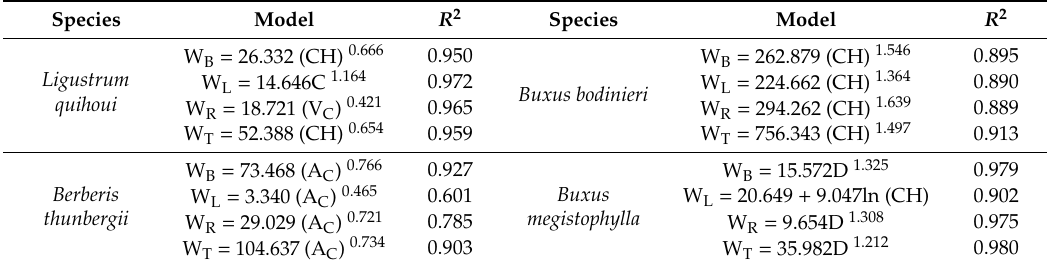
Table A3. Allometric biomass equation of shrubs, used for calculating quadrat biomass